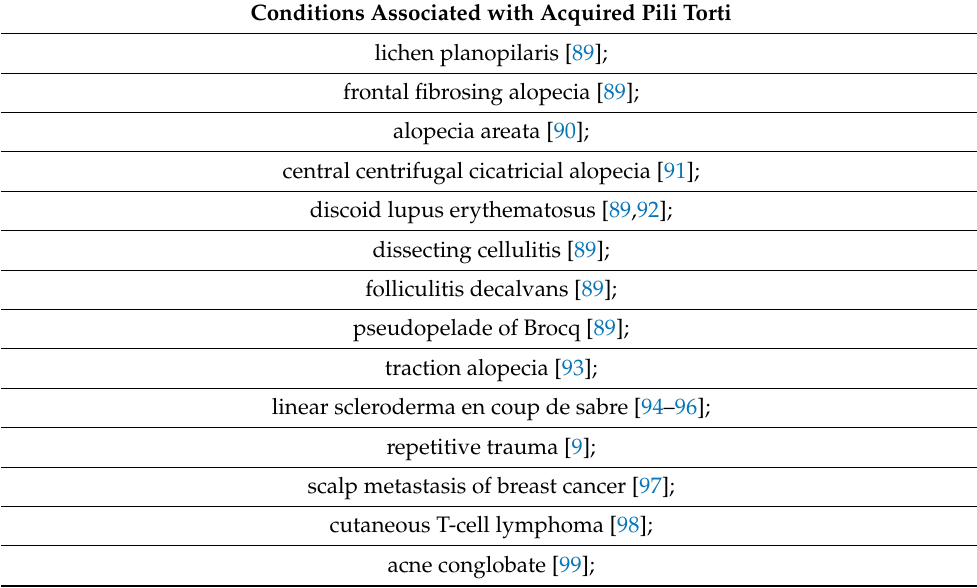
Table 3. Conditions associated with acquired pili